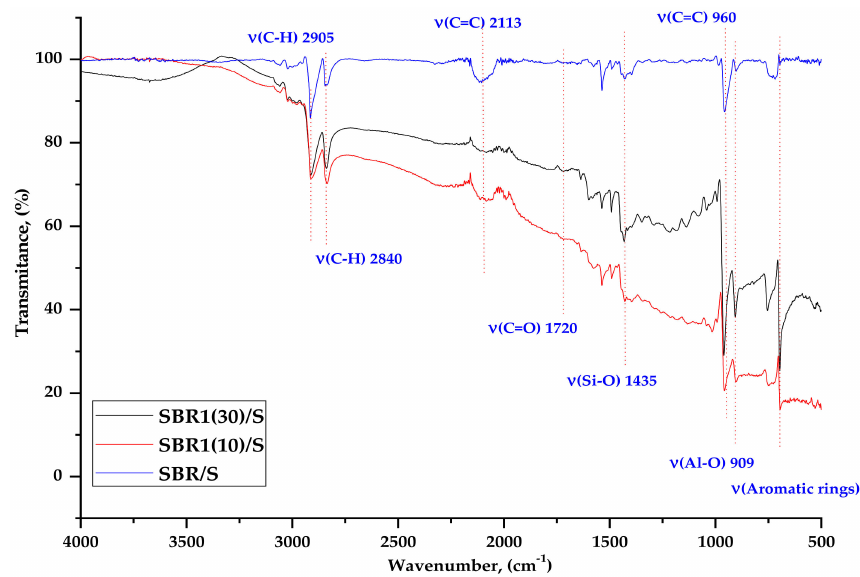
Figure 5. FTIR spectra for SBR, SBR1 (10), and SBR1 (30) after thermo-oxidative